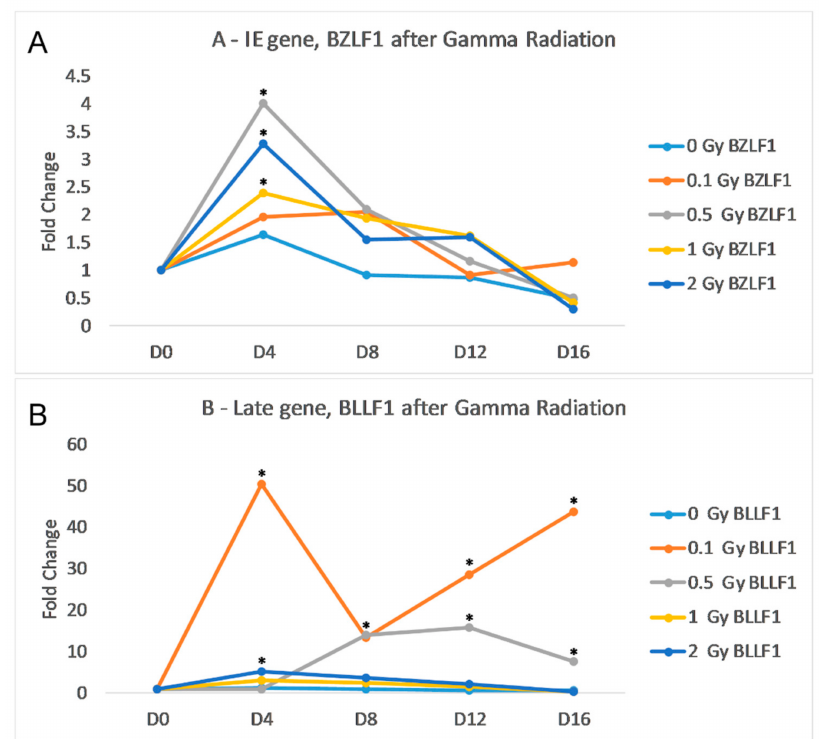
Figure 1. Effects of gamma radiation on Akata cells. Cells were radiated with 0.1 Gy (orange), 0.5 Gy (grey), 1 Gy (yellow) or 2 Gy (dark blue), then incubated for 16 days. The control flask (light blue) was not irradiated. ( A ) Fold change of IE gene BZLF1 transcripts normalized to endogenous control GAPDH over time relative to the control. ( B ) Fold change of L gene BLLF1 transcripts normalized to endogenous control GAPDH over time relative to the control. Statistical significance as compared to no radiation control and (two-tailed t test, * p <